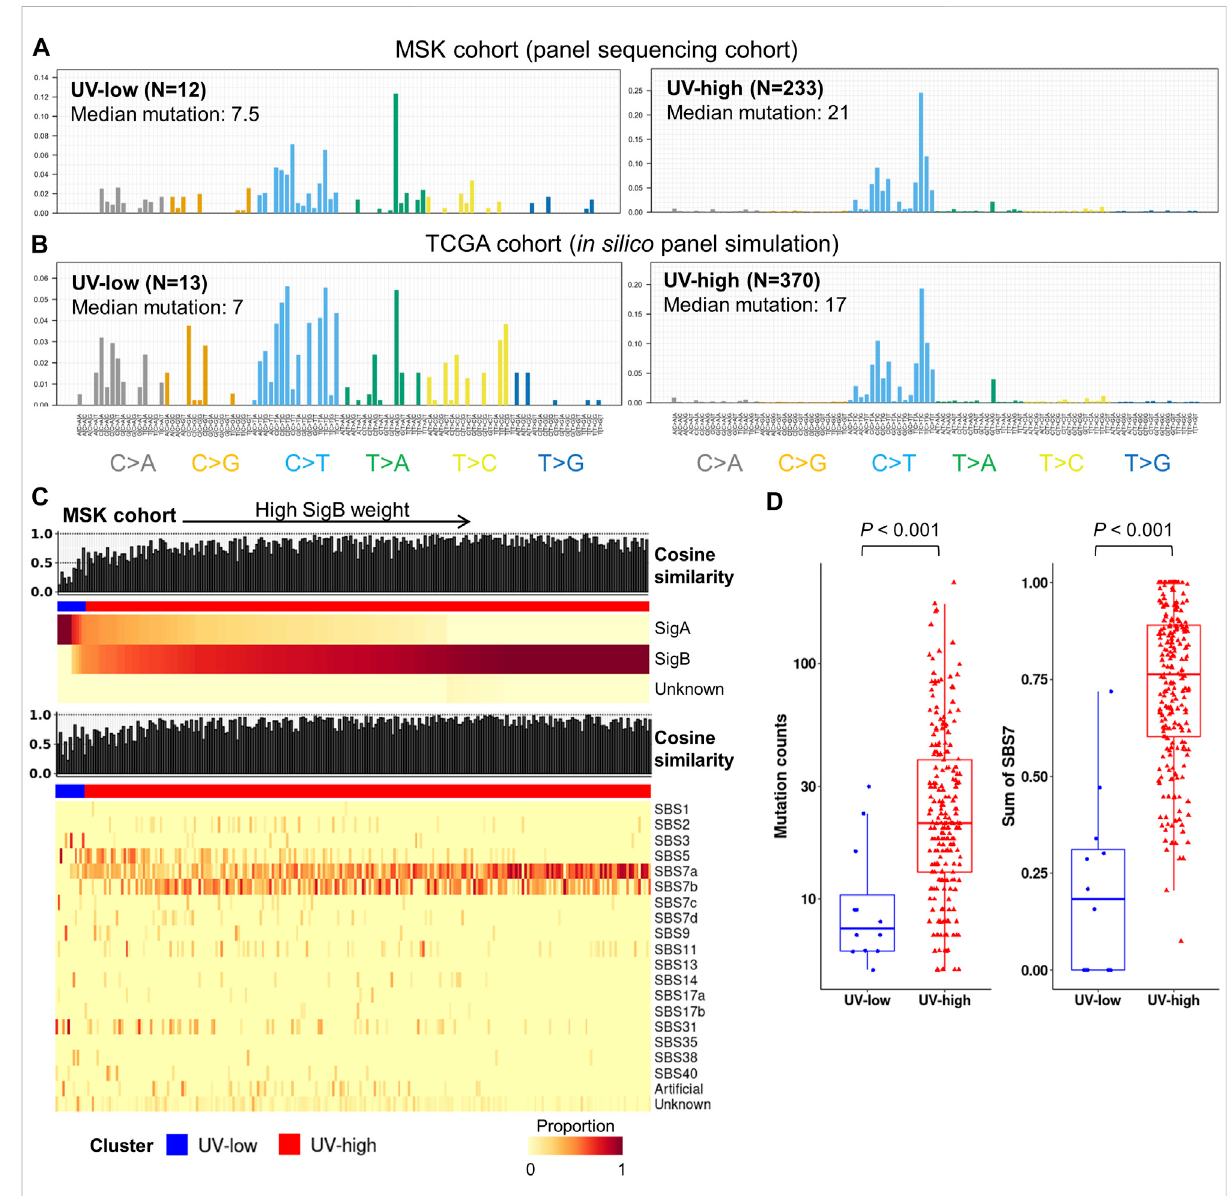
FIGURE 5 Independent panel sequencing cohort analysis and in silico panel simulation of TCGA cohort. (A) Average mutational context in independent panel sequencing cohort (MSK cohort), in which samples are classi fi ed by dominant signatures. (B) Average mutational context of UV-low and UV- high clusters from in silico panel simulation of TCGA cohort. Samples with less than fi ve single nucleotide variants of simulated data were excluded. (C) Signature decomposition analysis of MSK cohort by extracted signatures (top) and known COSMIC signatures (bottom). Samples (column) werearrangedbytheweightofSigB,andcolumnbarindicatesclusters. (D) BoxplotsshowingmutationcountsandSBS7signatures(SBS7a/7b/7c/7d) for each cluster in MSK cohort. p -value was calculated using a two-sided Mann-Whitney U